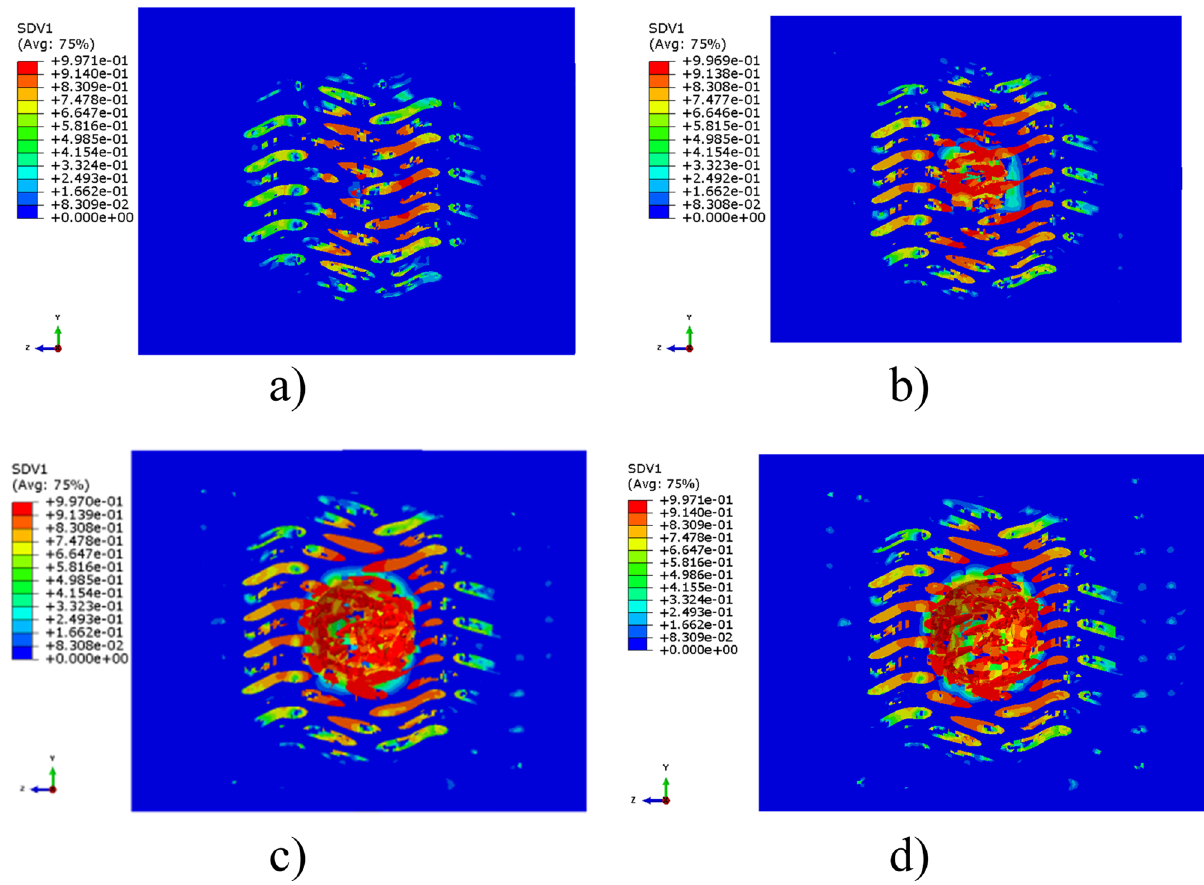
Figure 19: Longitudinal tensile damage of the specimens after a di ff erent number of impact tests: ( a ) 1st impact, ( b ) 5th impact, ( c ) 10th impact, and ( d ) 20th